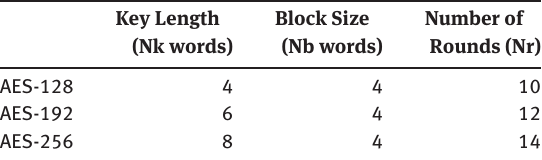
Fig. 2: Asymmetric encryption/decryption